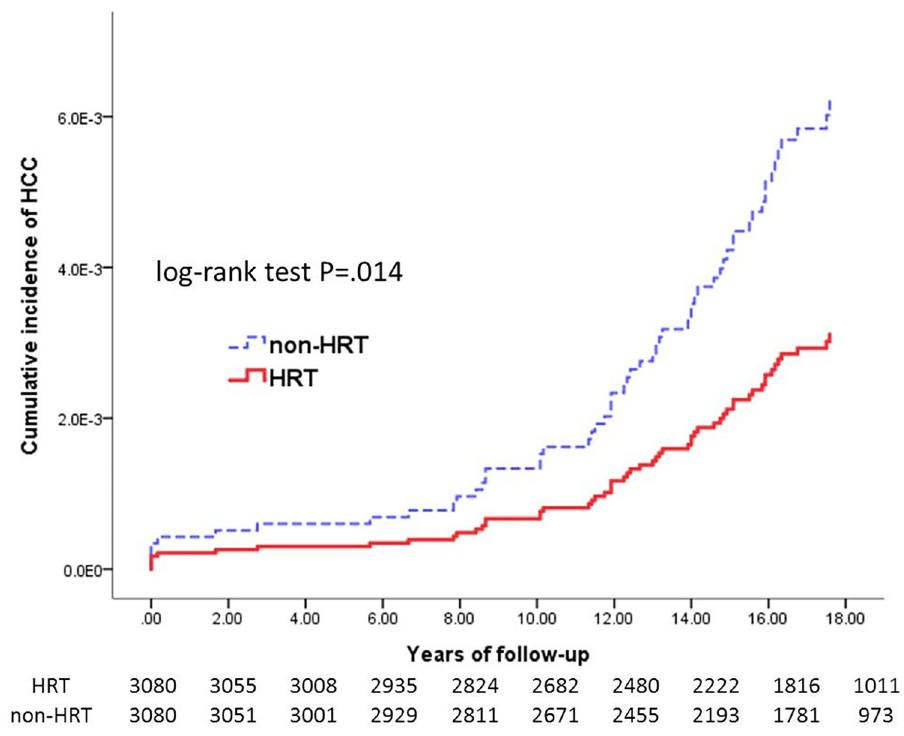
Fig 2. Cumulative incidence of hepatocellular carcinoma between the HRT and non-HRT cohorts. HRT, hormone replacement therapy; HCC, hepatocellular